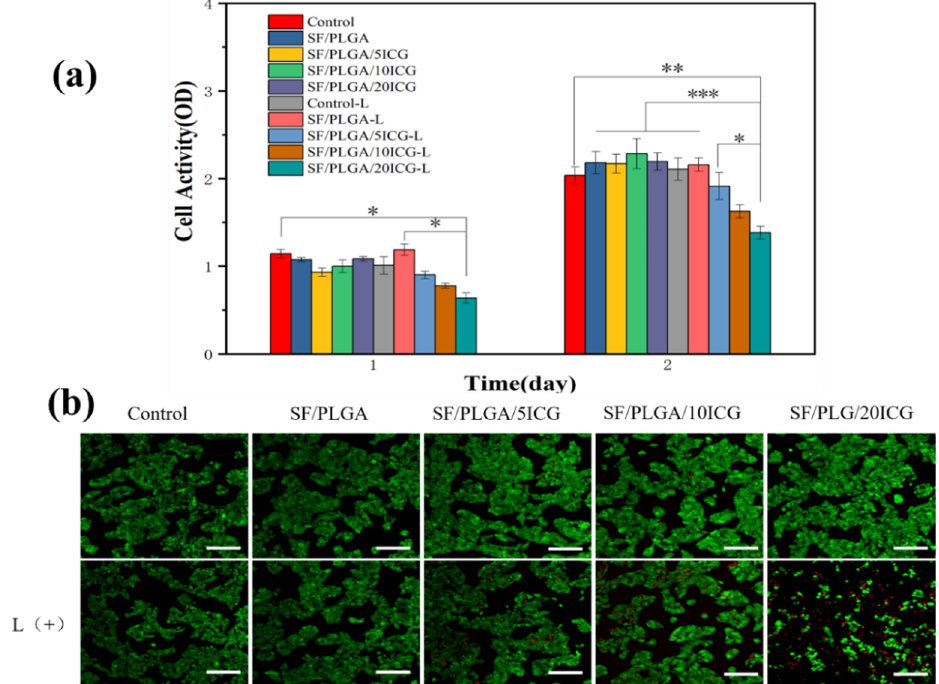
Figure 7. In vitro antitumor efficacy. ( a ) Effects of the nanofibrous membranes on the viability of HepG2 cells; ( b ) live cell staining of HepG2 cells examined by confocal microscopy (bar = 100 μ m). * p < 0.05, ** p < 0.01, *** p < 0.001, data represent means ± SD (n = 3).